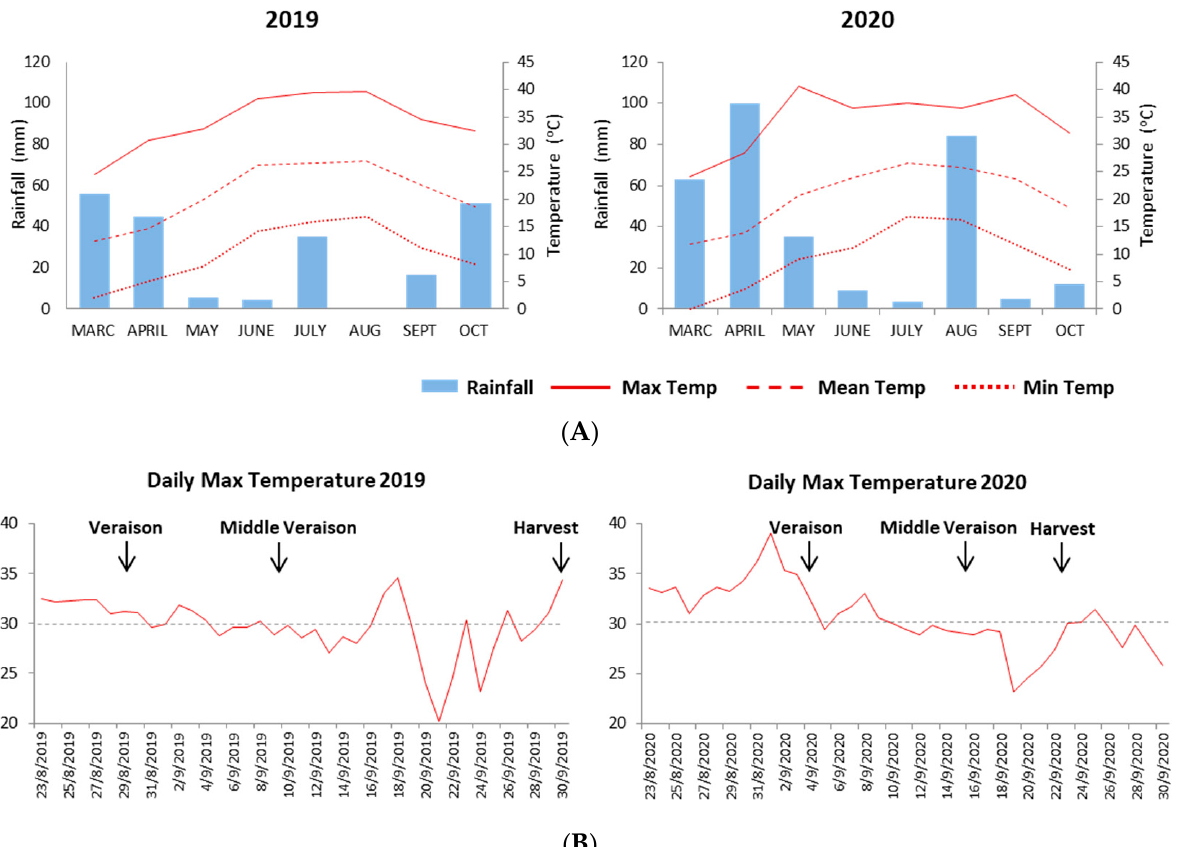
Figure 1. ( A ) Monthly evolution of temperatures and rainfall recorded in the Muses Valley during 2019 and 2020; ( B ) Daily evolution of maximum temperatures (above 30 °C) recorded in the Muses Valley during 2019 and 2020. Arrows indicate the three sampling dates (veraison, middle veraison and harvest).